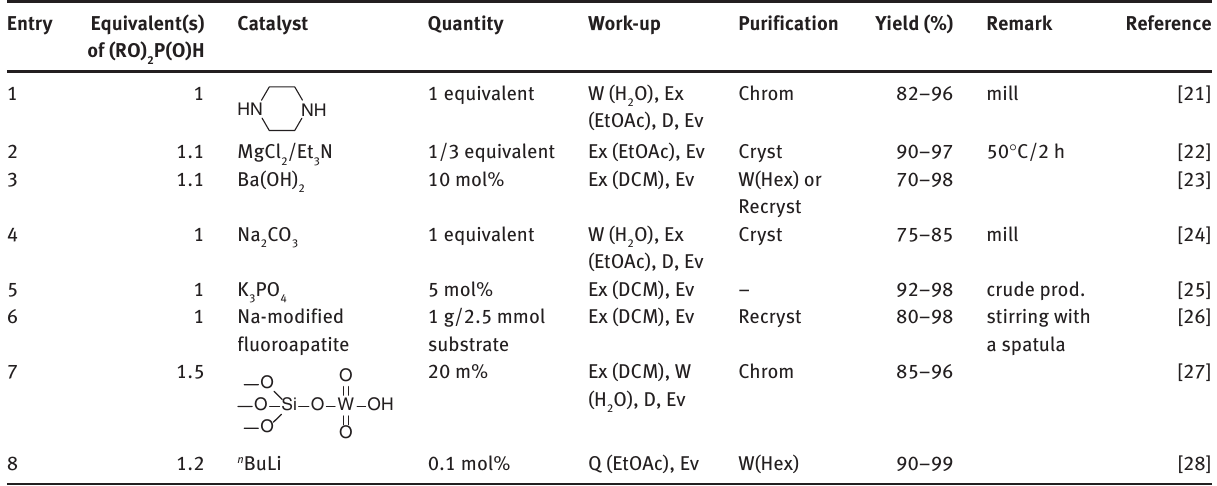
Table 1: Green “solvent-free” preparation of α -hydroxyphosphonates as described in the literature. Entry Equivalent(s) of (RO) 2